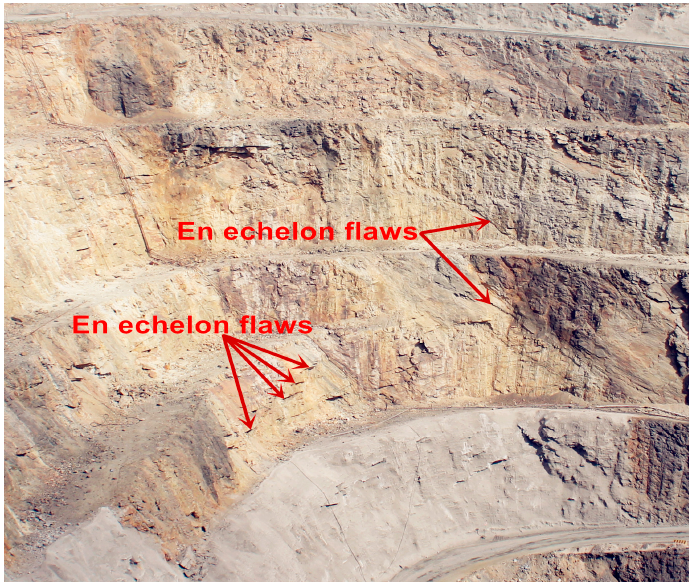
Figure 1. Rock mass structure containing en echelon flaws in an open-pit mine.